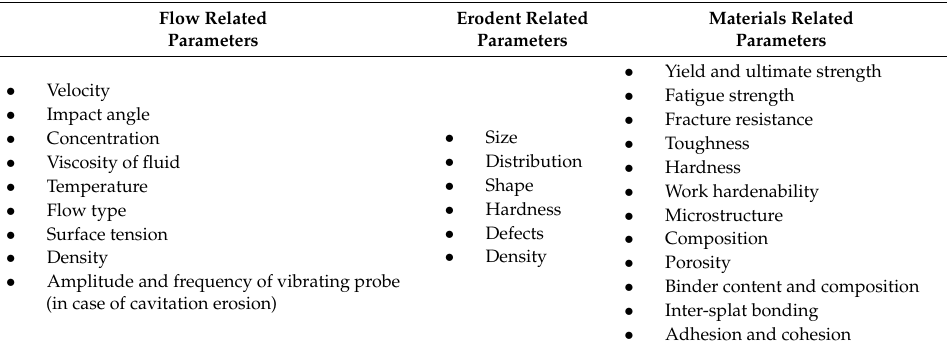
Table 1. Process parameters that affect the erosion process [24].